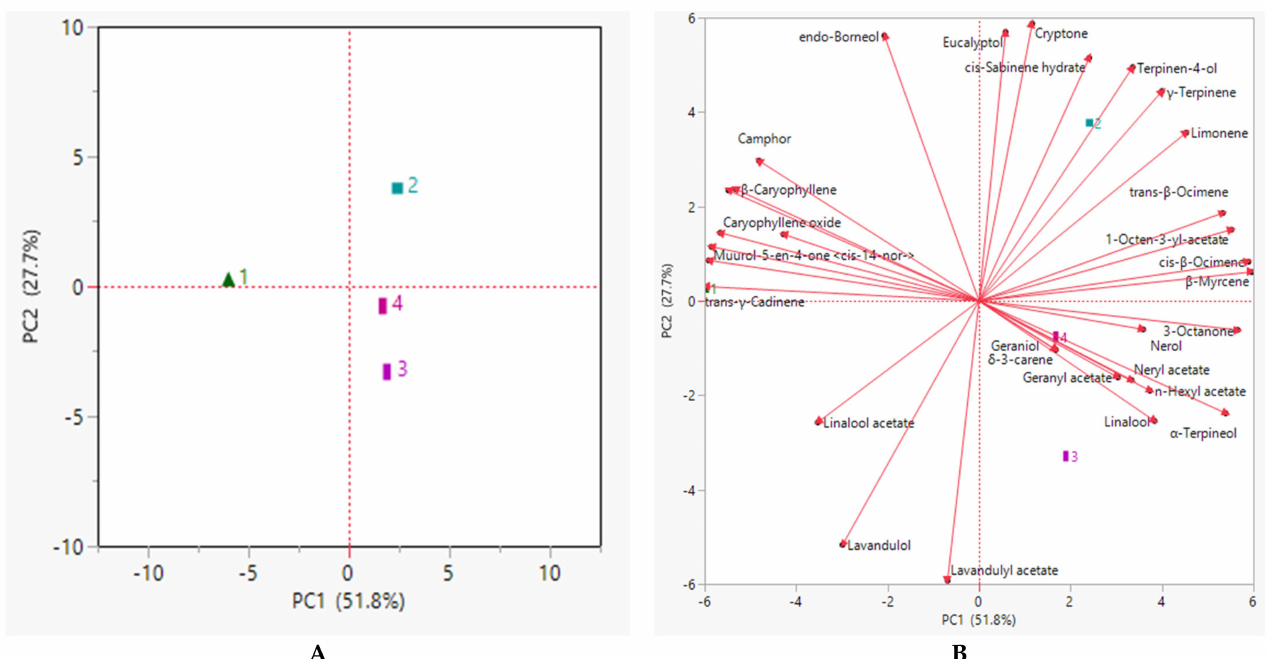
Figure 1. Principal component analyses of the essential oil composition of Lavandula angustifolia collected during four consecutive years. ( A ) Loading Plot; ( B ) Biplot.